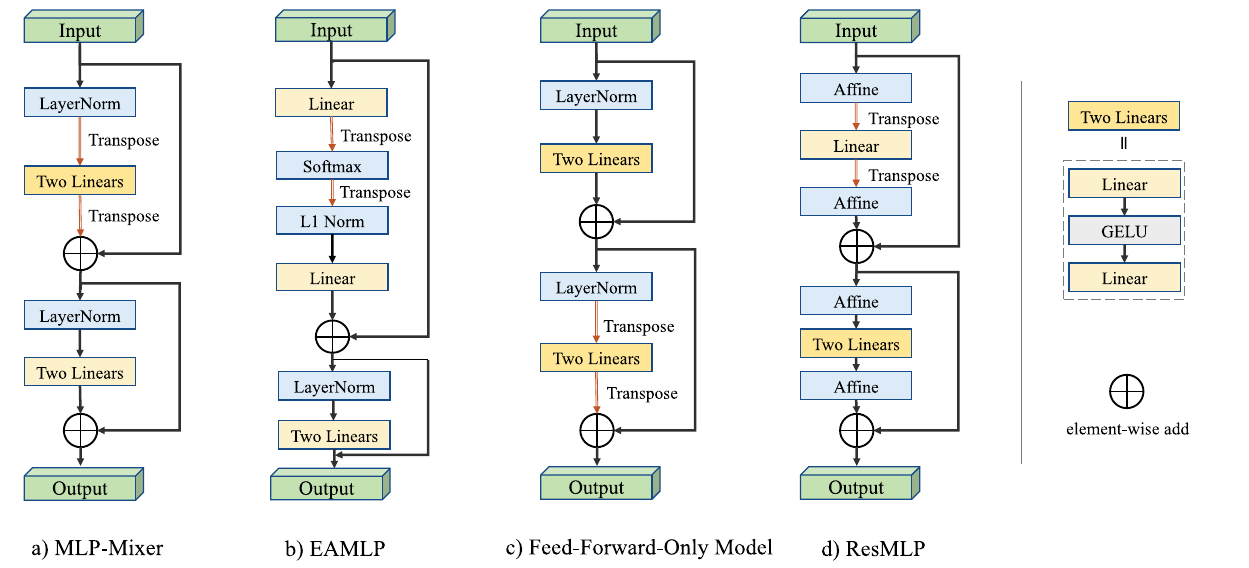
Fig. 1 Basic blocks of four recent architectures in which linear layers